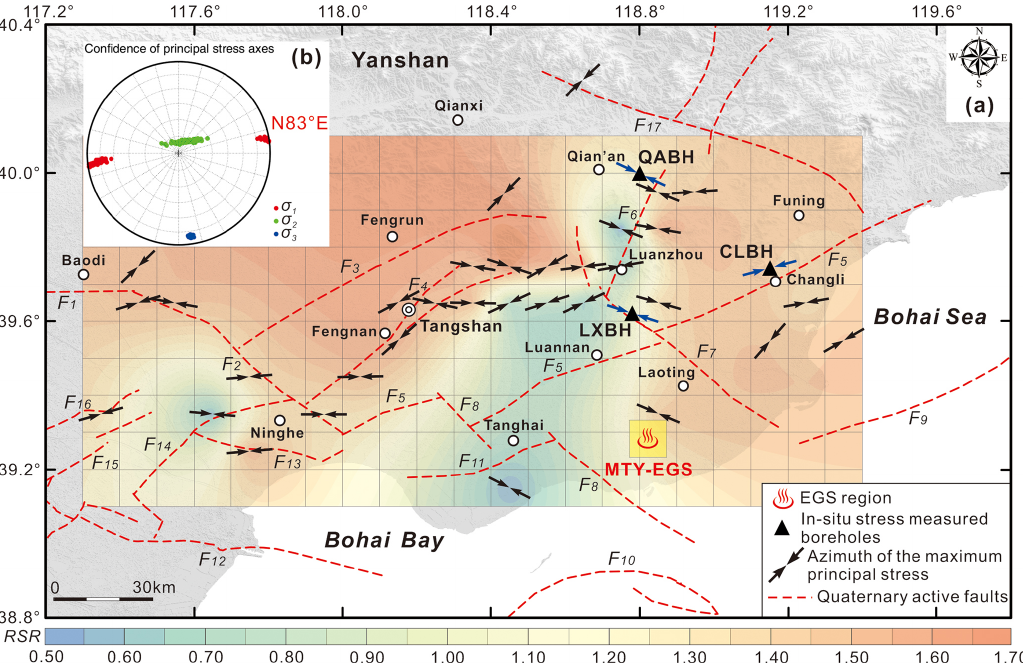
Figure 3. Crustal stress field in the Tangshan seismic region, as determined by inversion of 98 focal mechanisms shown in Fig. 2 using the STRESSINVERSE software package (Vavryˇcuk, 2014). (a) The results of the inversion in each bin (0 . 1 ◦ × 0 . 1 ◦ ) include the predominant maximum principal compressive stress orientation ( σ 1 ) and the regime stress ratio (RSR). (b) The dominant σ 1 orientation in the Tangshan seismic region was constrained using all 98 focal mechanisms with a confidence interval of 95%.